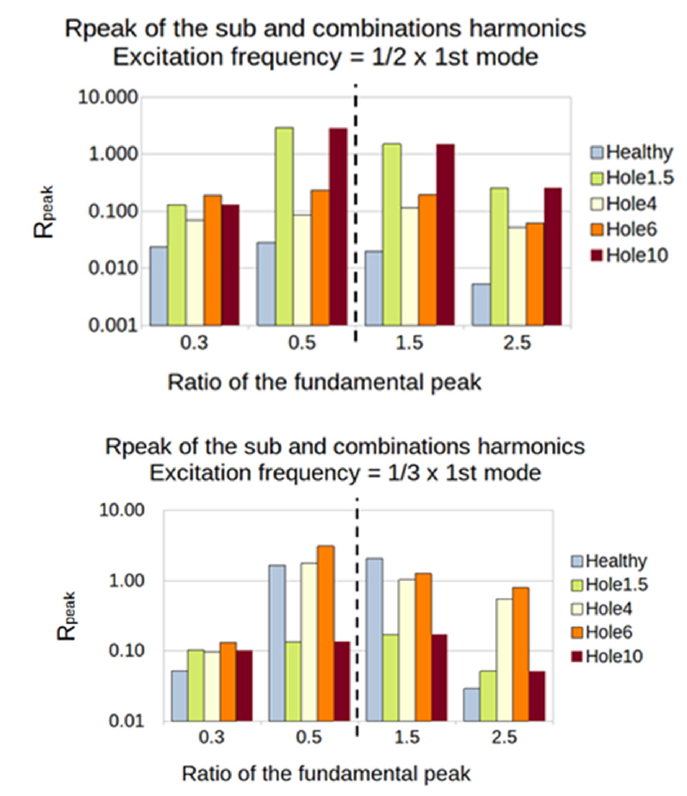
Figure 19. First natural frequency and its ratio of 1, 1/2, and 1/3 as the frequency of excitation for the PVDF sensor.